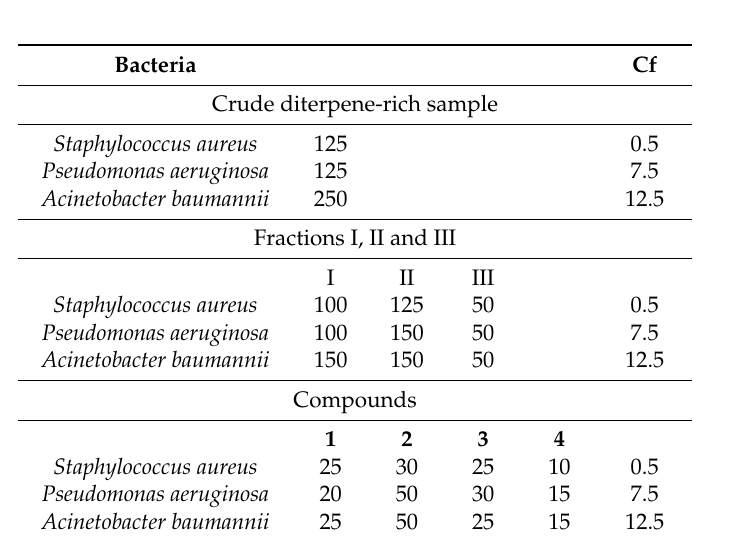
Table 1. Antimicrobial activity of the crude diterpene-rich sample, fractions and, compounds (MIC in µ